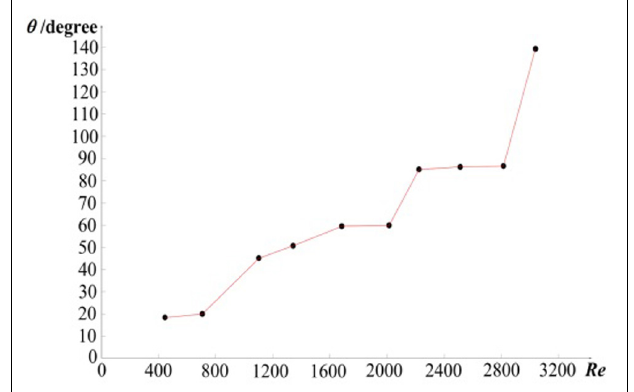
FIGURE 5 | Curve of angle between the two strip-shaped liquid films (ATSSLF) and Reynolds